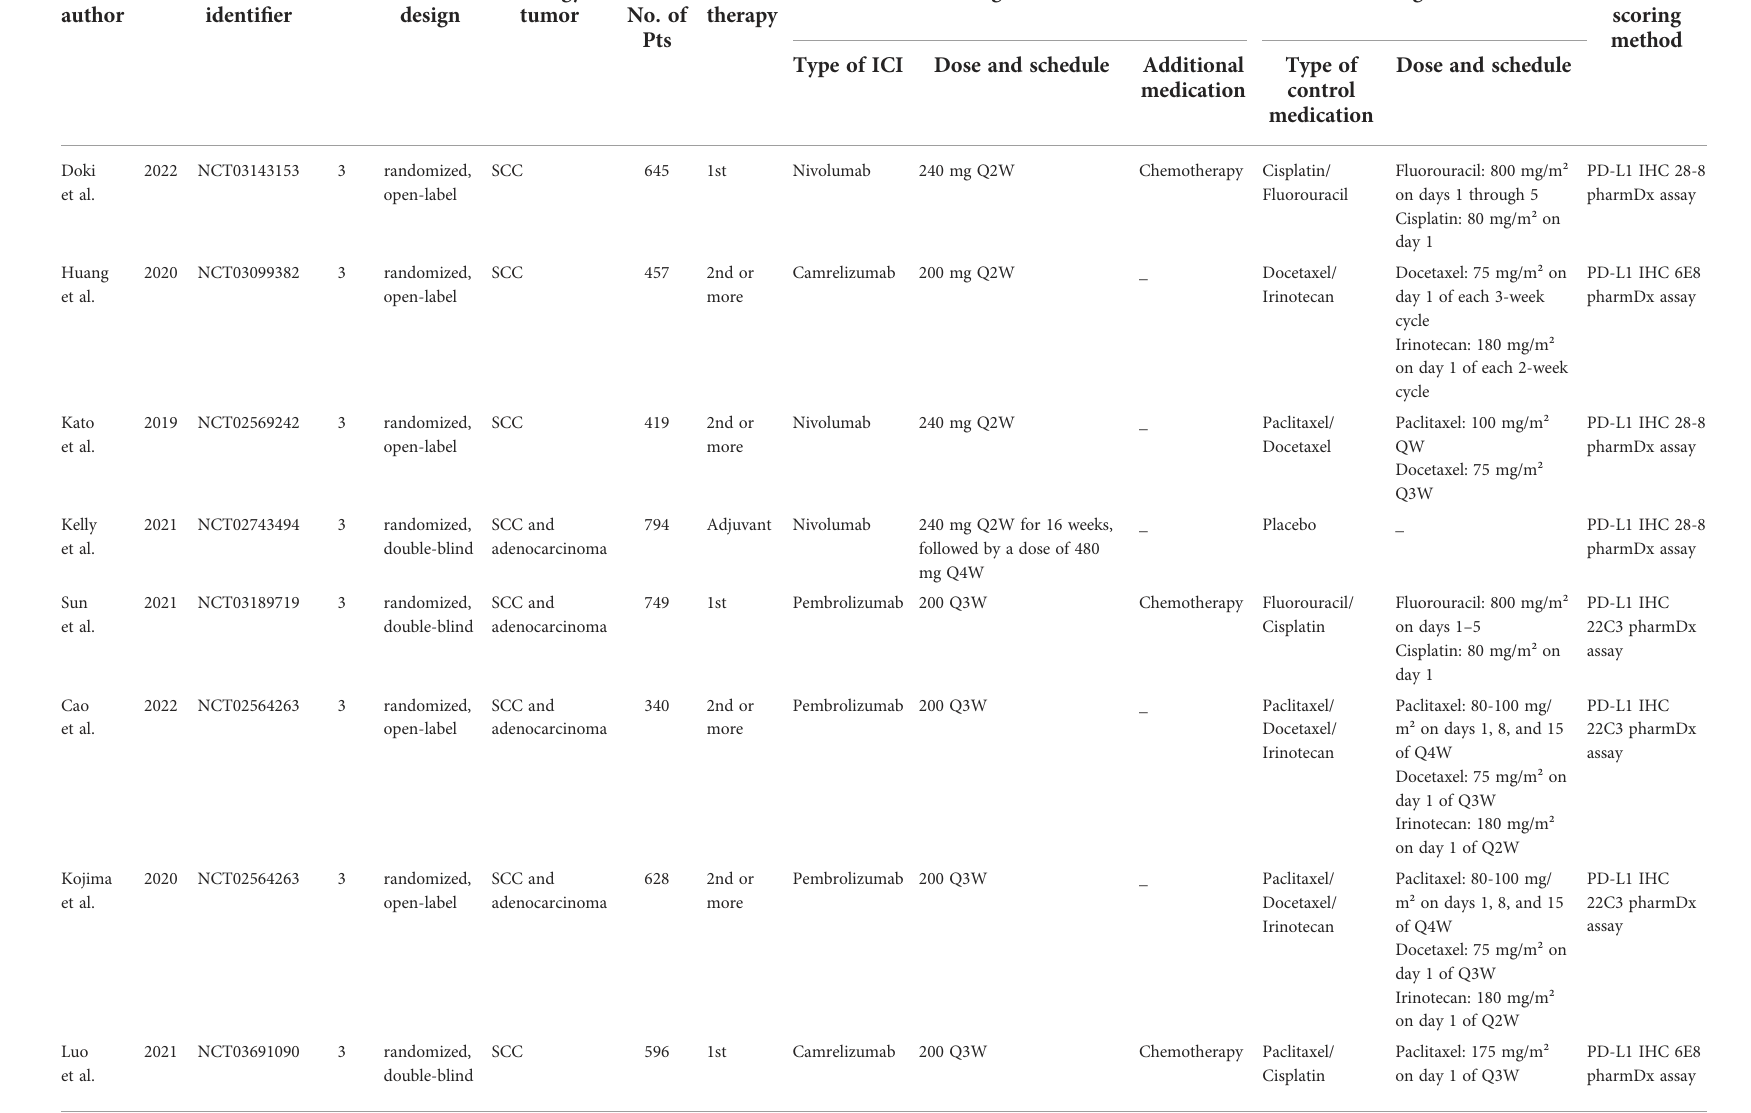
TABLE 1 Characteristics of the included